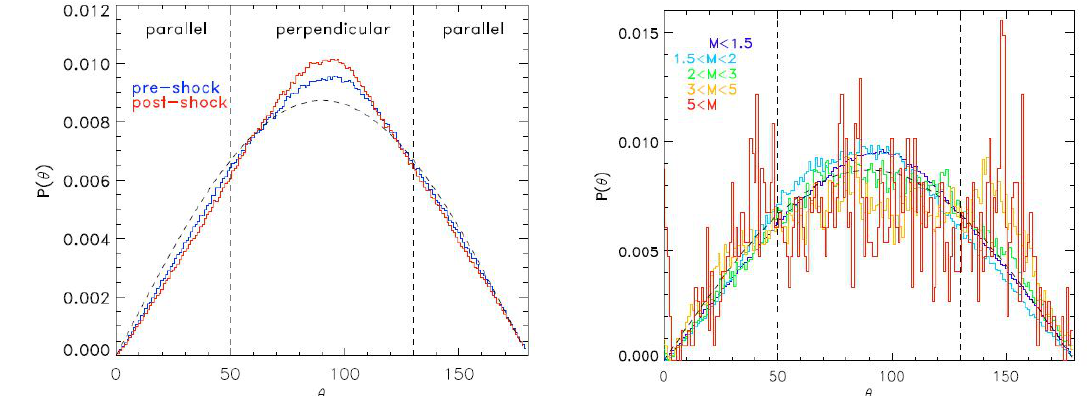
Figure 2. Distributions of shock obliquities at z ≈ 0.2. The left panel shows the pre-shock ( blue ) and post-shock ( red ) distribution of obliquities. The black dashed line shows the expected ∝ sin ( α ) distribution of angles based on pure geometry. The right panel shows the distribution of pre-shock obliquities for different ranges of Mach numbers: M < 1.5 ( dark blue ), 1.5 < M < 2 ( light blue ), 2 < M < 3 ( green ), 3 < M < 5 ( orange ) and M > 5 ( red